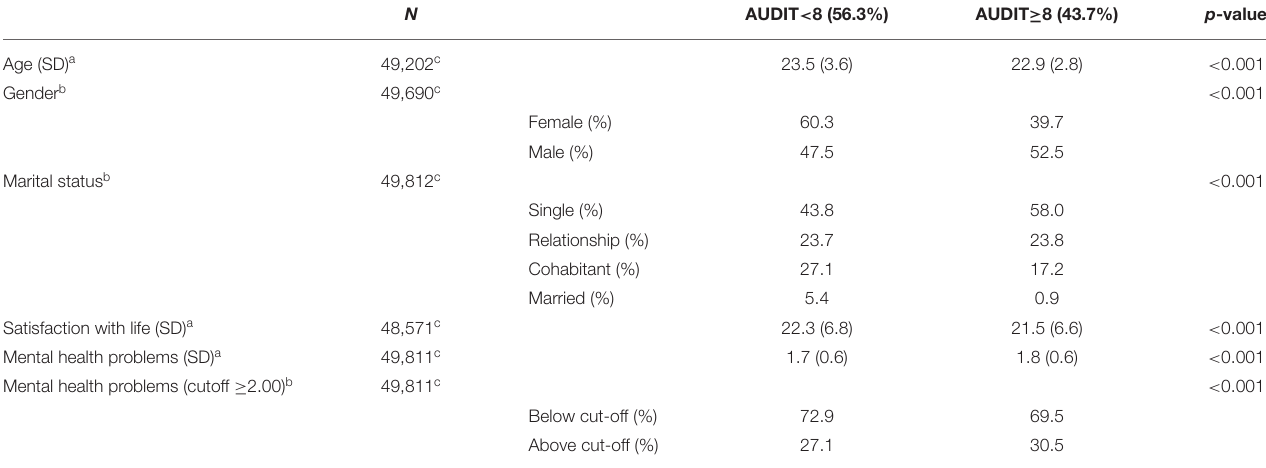
TABLE 2 | Characteristics of the sample across AUDIT scores < 8 vs. ≥